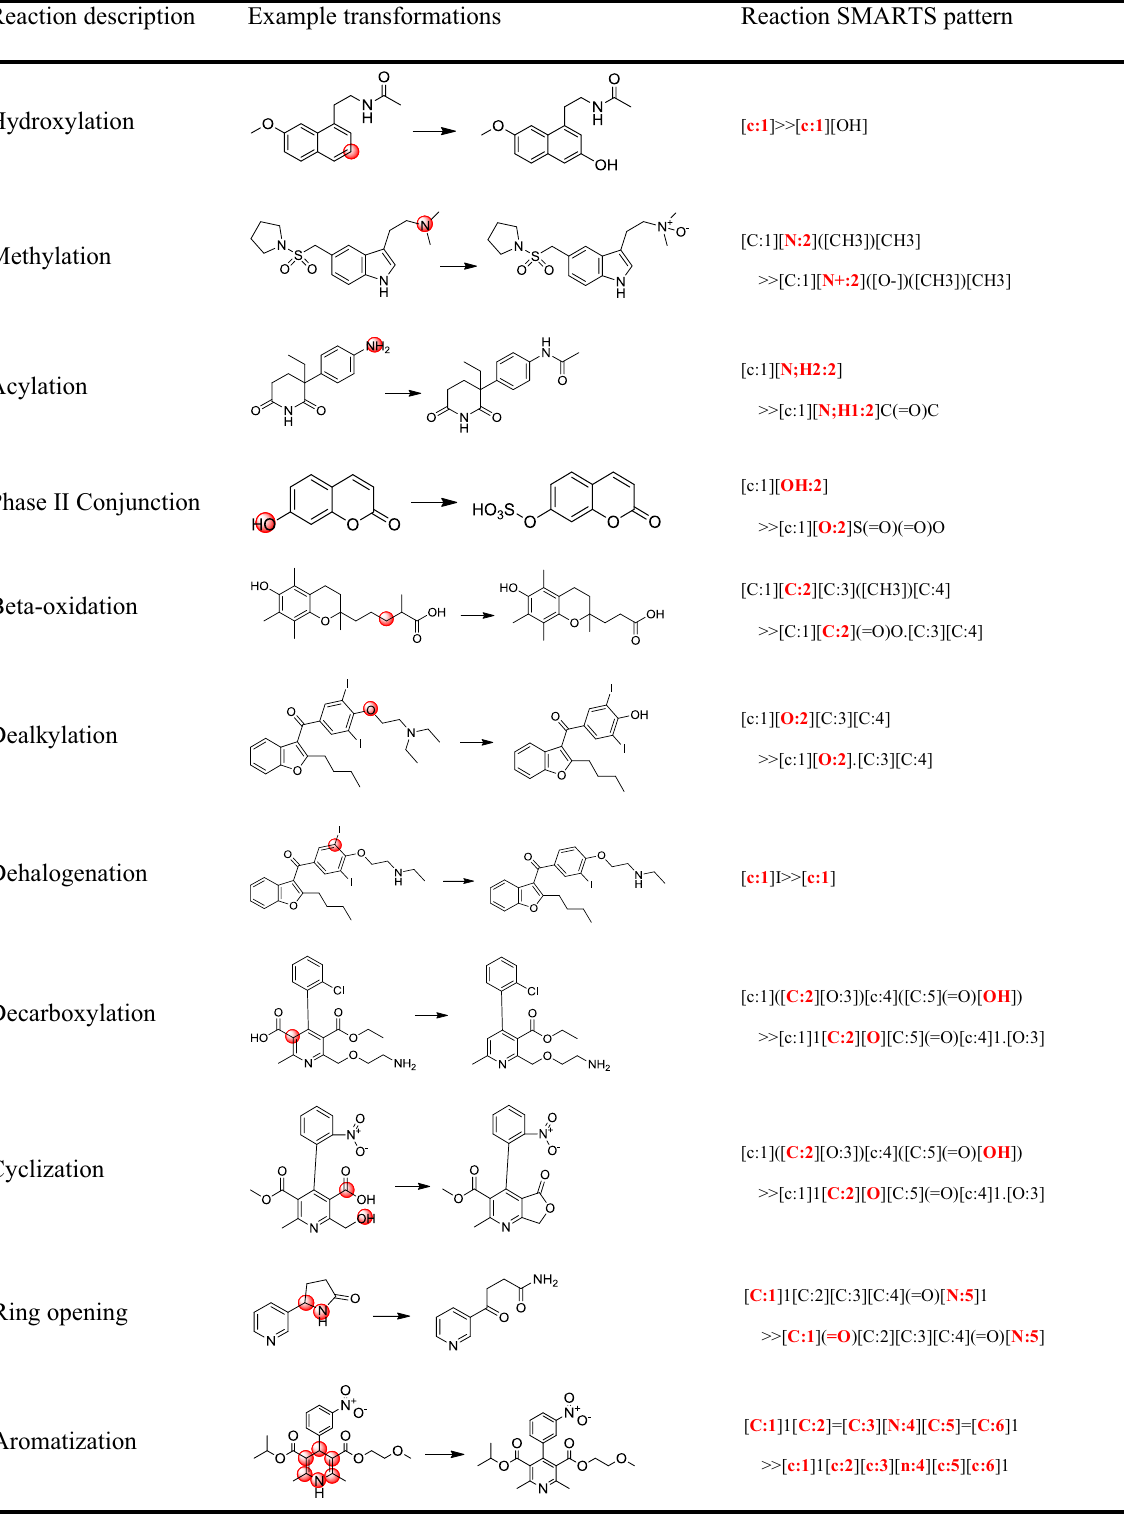
Table 1 Examples of identifying SOMs of simple and complex biotransformation reactions through reaction SMARTS